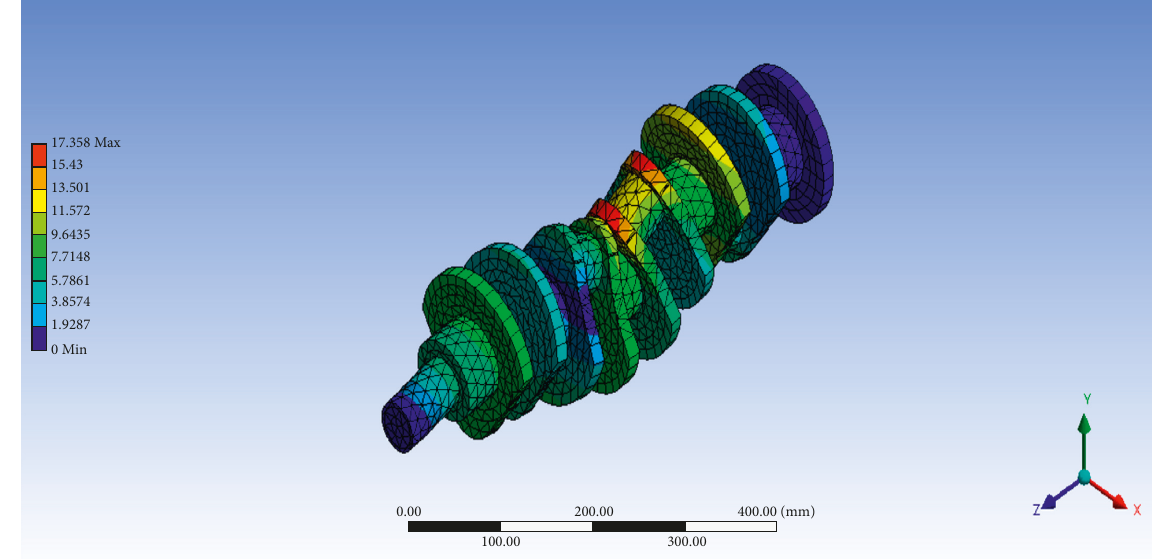
Figure 20: Deformation of FGM crankshaft at the fourth mode of vibration.